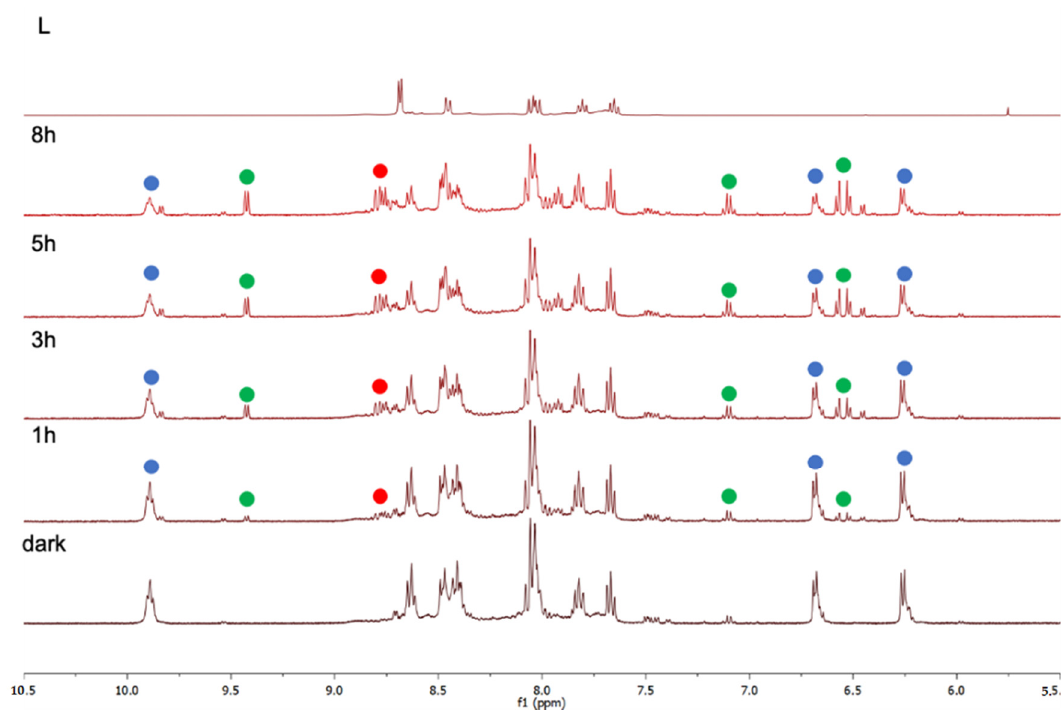
Figure 2 . Evolution of NMR spectra of complex C after 1, 3, 5 and 8 h of photoactivation and pure free ligand L for comparison.